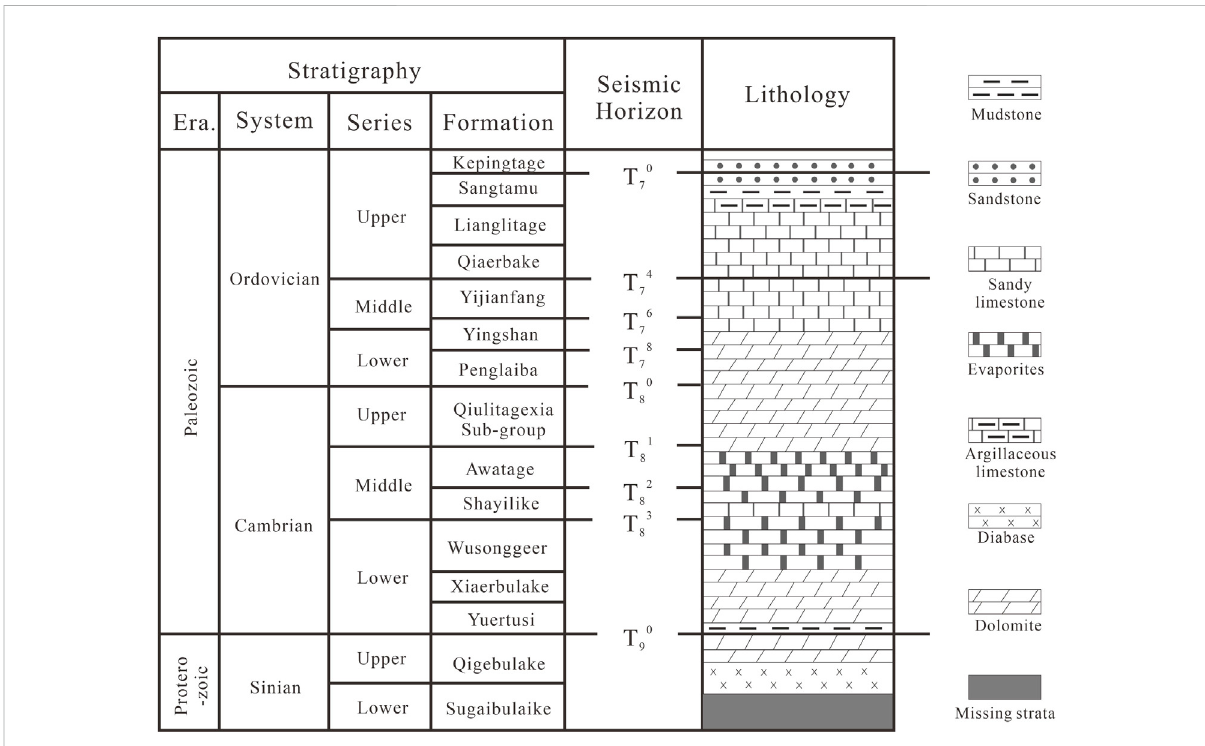
Stratigraphic, seismic horizon, and lithologic information of the Shunbei Oil fi eld (slightly modi fi ed from Deng et al.,